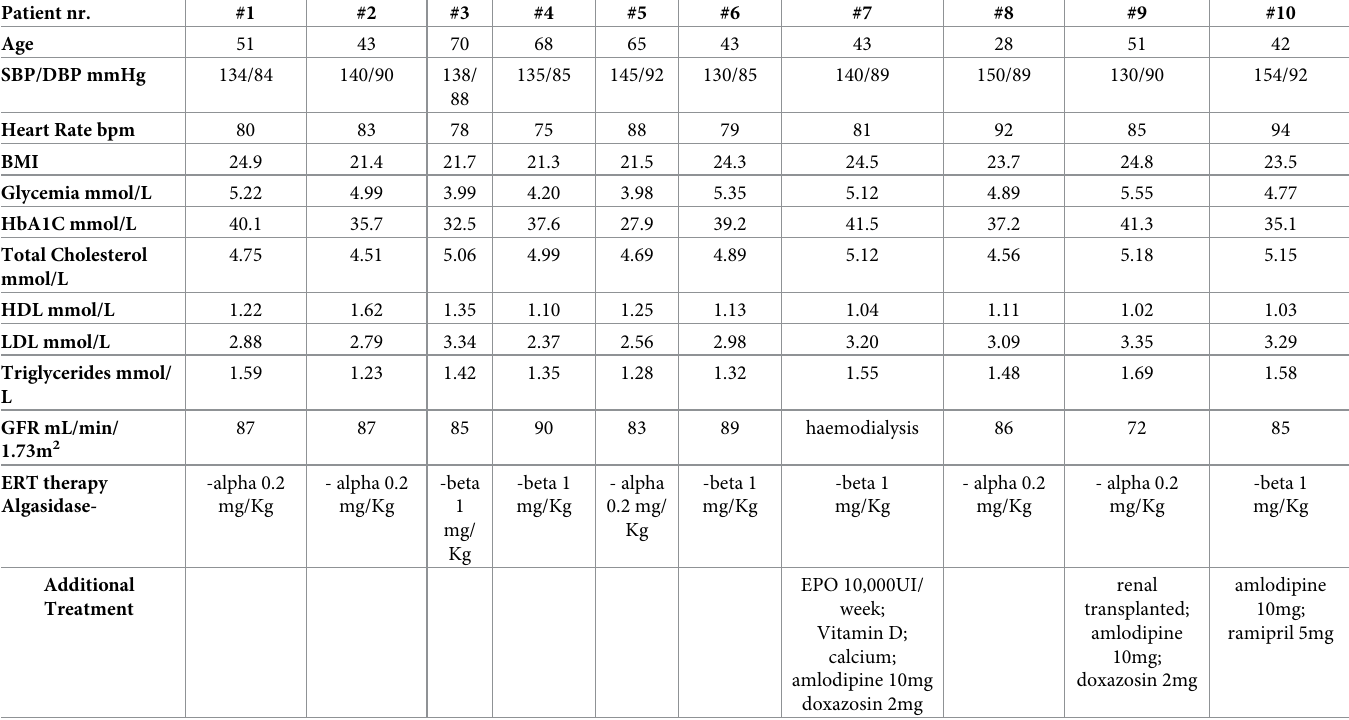
Table 2. Patients characteristics. Patient